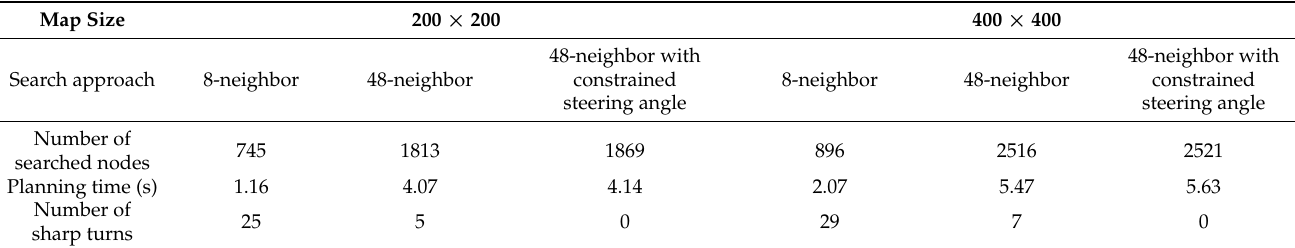
Table 3. Number of exceeding steering angles.